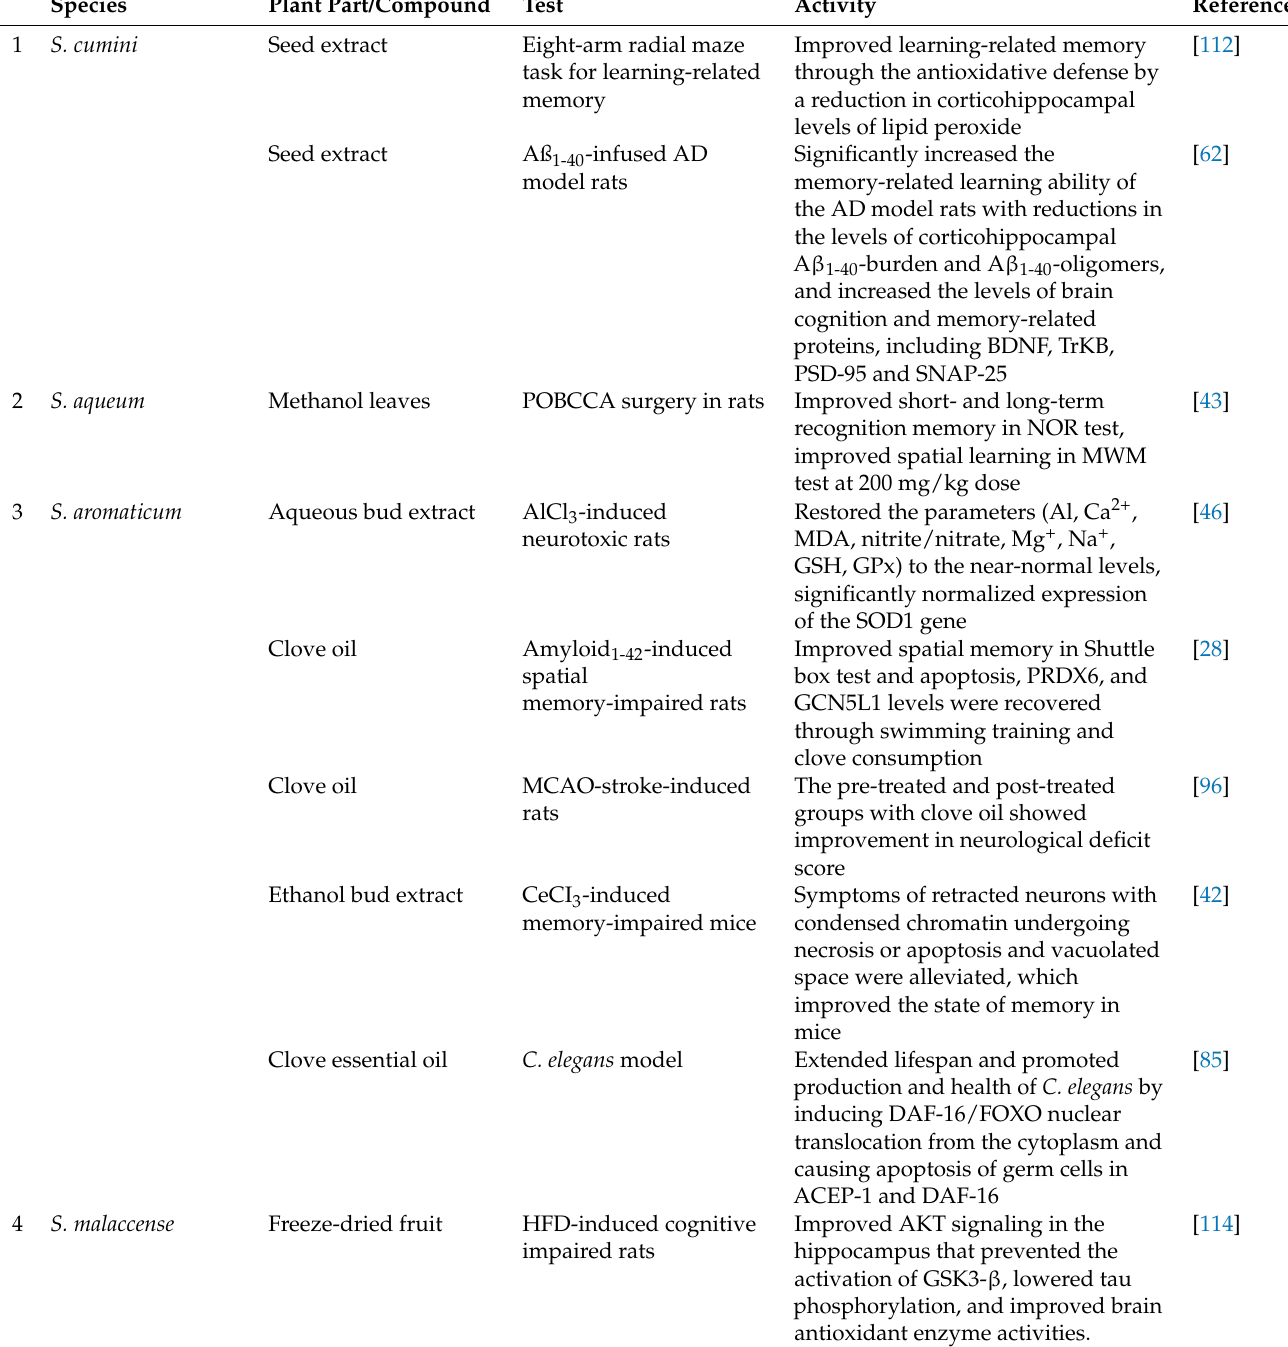
Table 4. Reported in vivo studies related to neuroprotection or aging from Syzygium